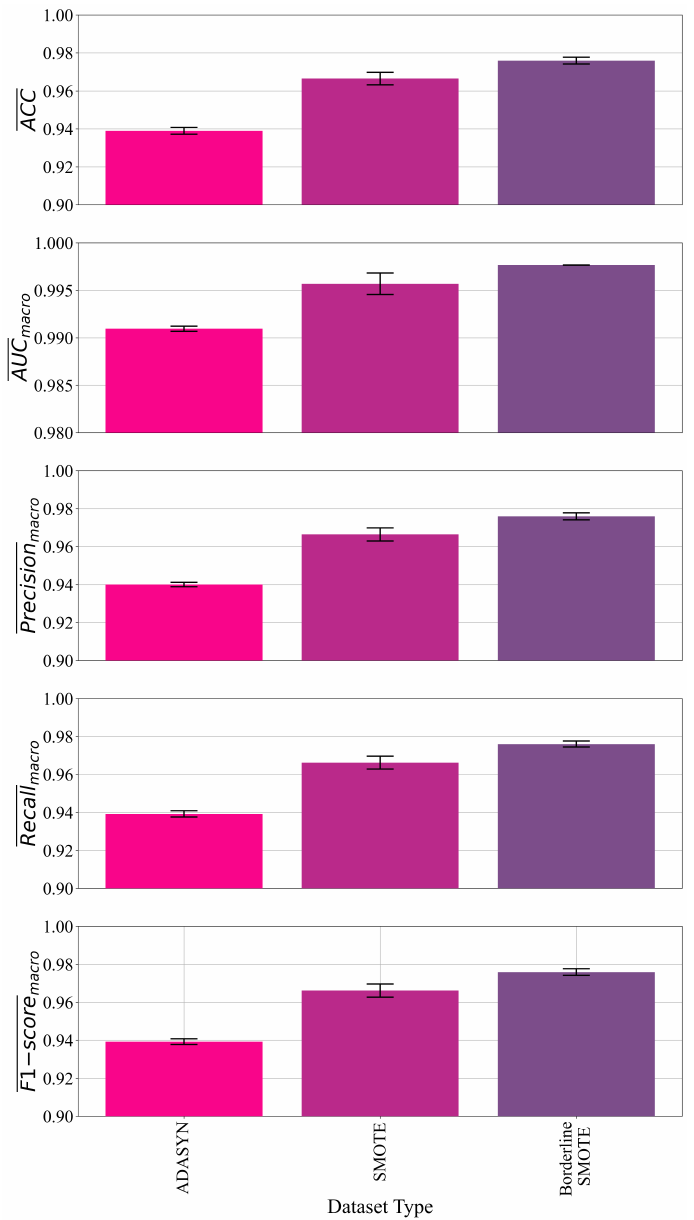
Figure 7. The mean and standard deviation (error bars) values of ACC , AUC , precision , recall , and F 1 − score achieved for different dataset